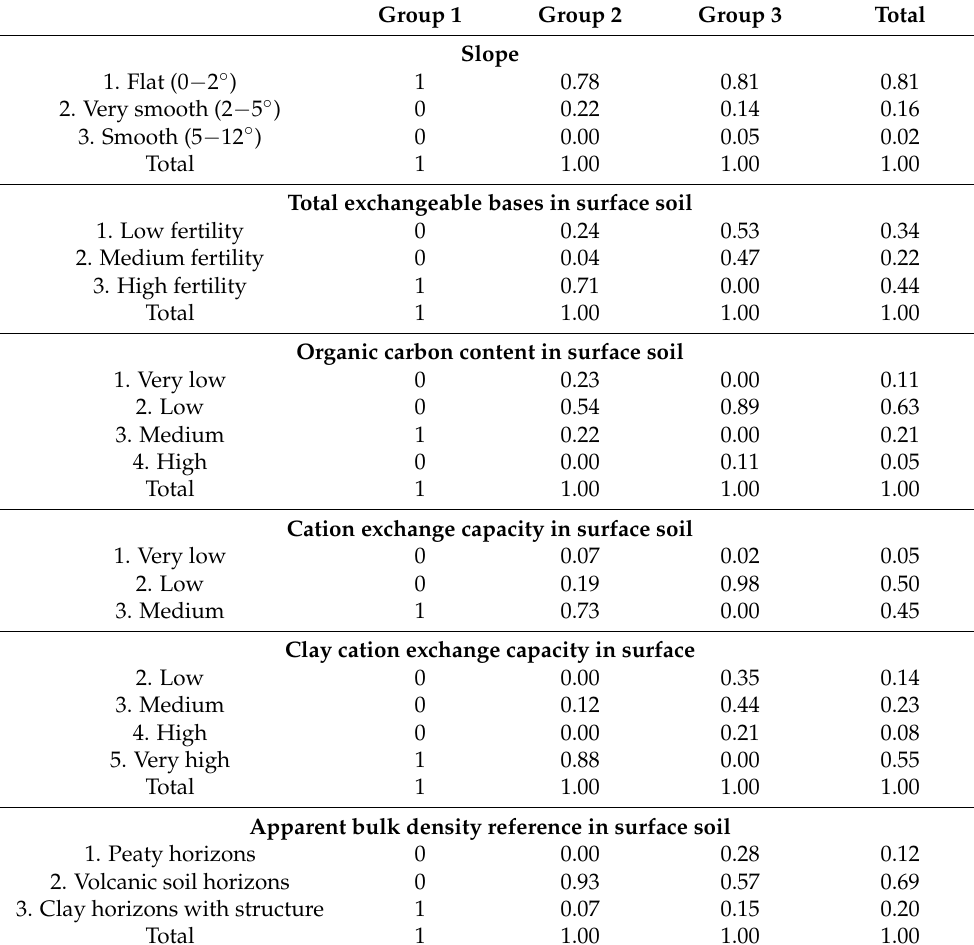
Table A5. Ecogeographic variation of qualitative characters based on the grouping of dendrograms for the Ecuadorian cassava